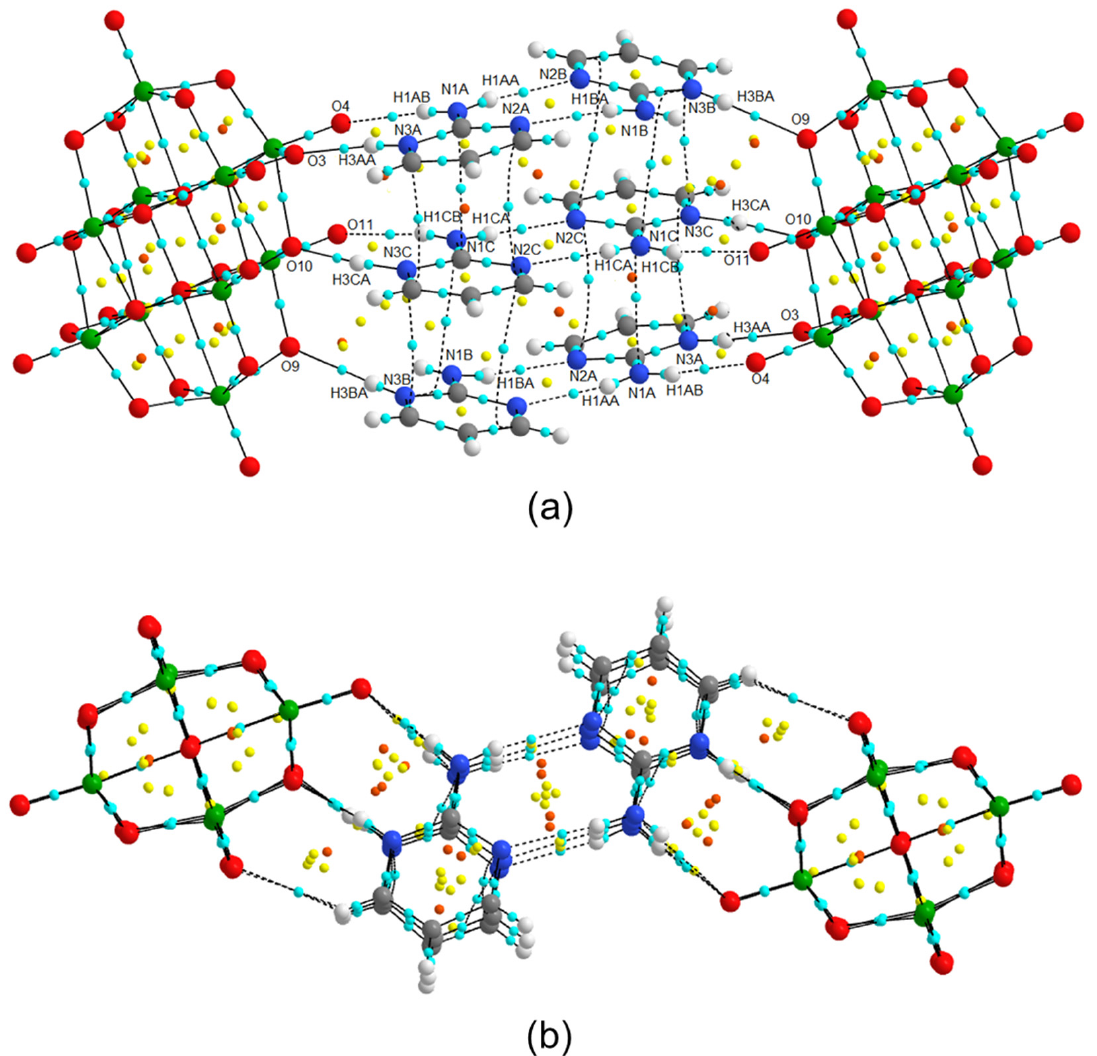
Figure 9. Molecular graphs of Compound 1 : ( a ) showing the main H-bridge bonds between the decavanadate anion and pyrimidine molecules, ( b ) the interactions and the π -stacking arrangement between the pyrimidine rings as seen from a perpendicular orientation. Vanadium atoms are represented in green. Blue dots represent bond critical points (BCPs), yellow dots represent ring critical points (RCPs), and orange dots represent cage critical points (CCPs). Table 5. Topological parameters (in a.u.), interaction energies E H···Y (in kcal mol − 1 ), and interatomic distances D int (in Å).